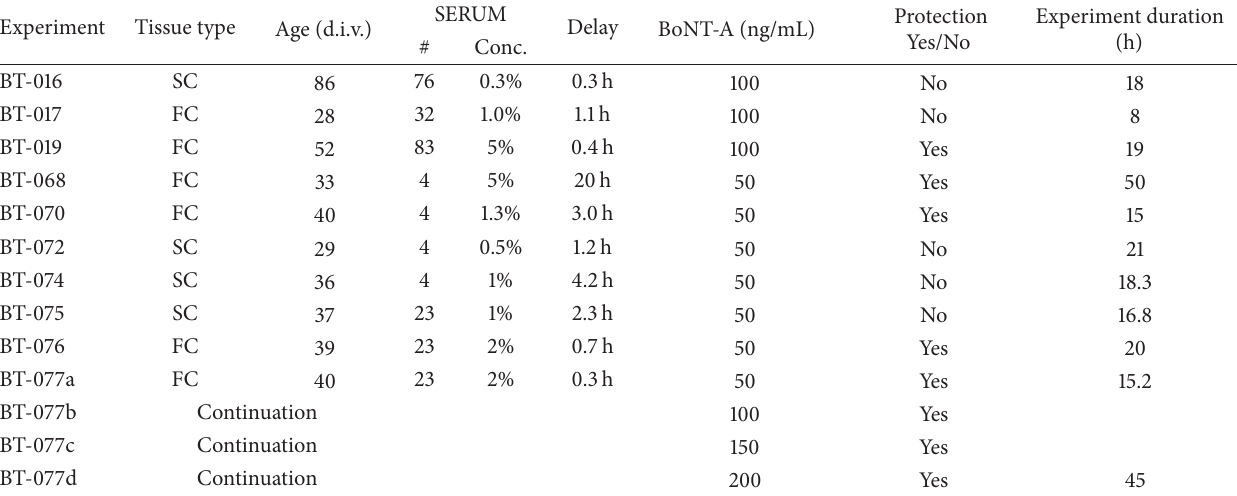
Table 1: Antisera protection experiments.